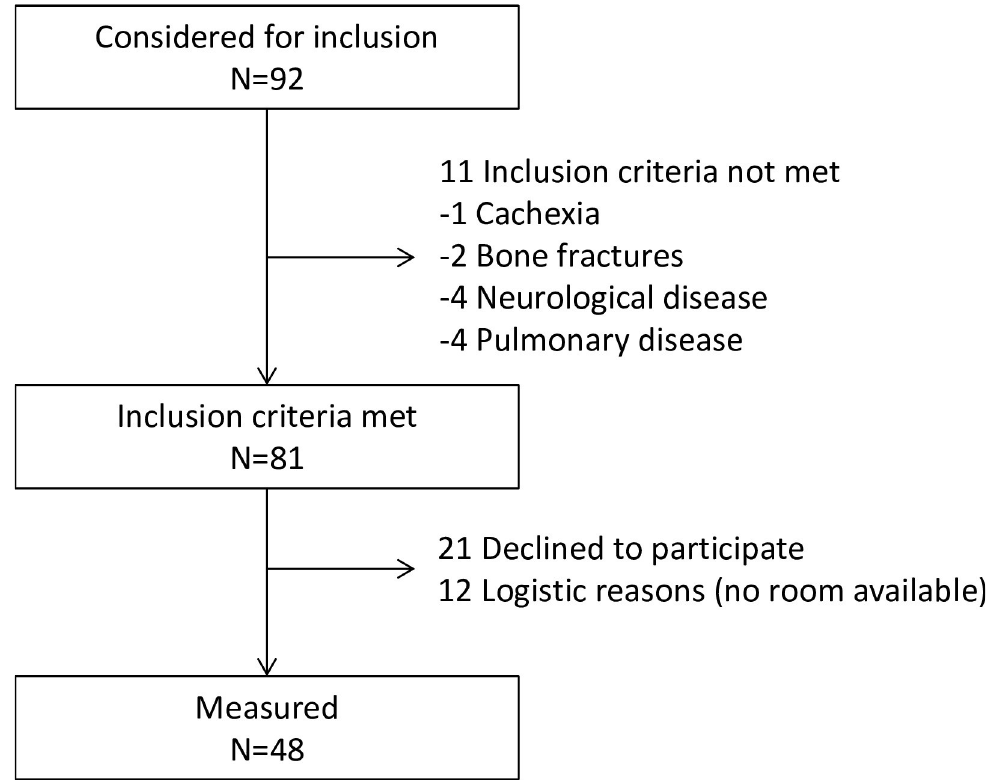
Fig 1. Flowchart of patient